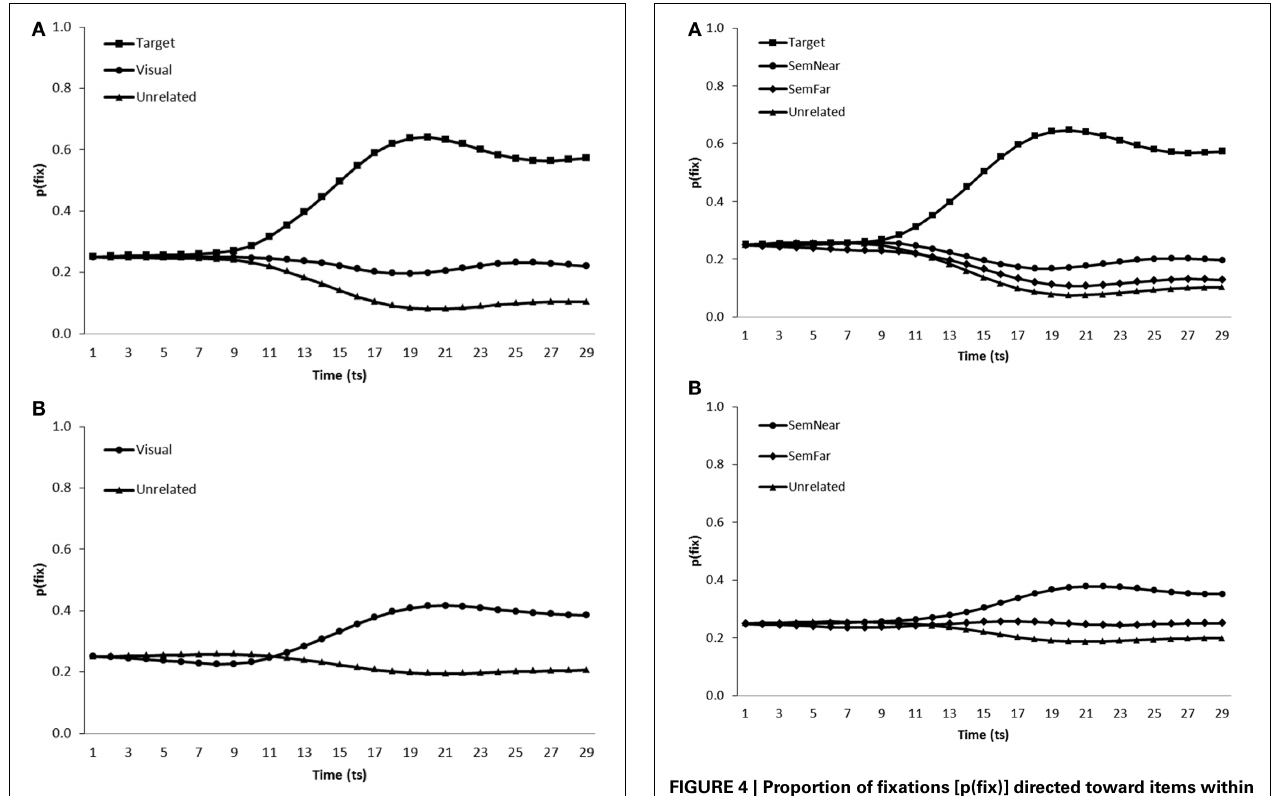
FIGURE 3 | Proportion of fixations [p(fix)] directed toward items within scenes containing (A) a target, visual competitor and two unrelated distractors (B) a visual competitor and three unrelated distractors.